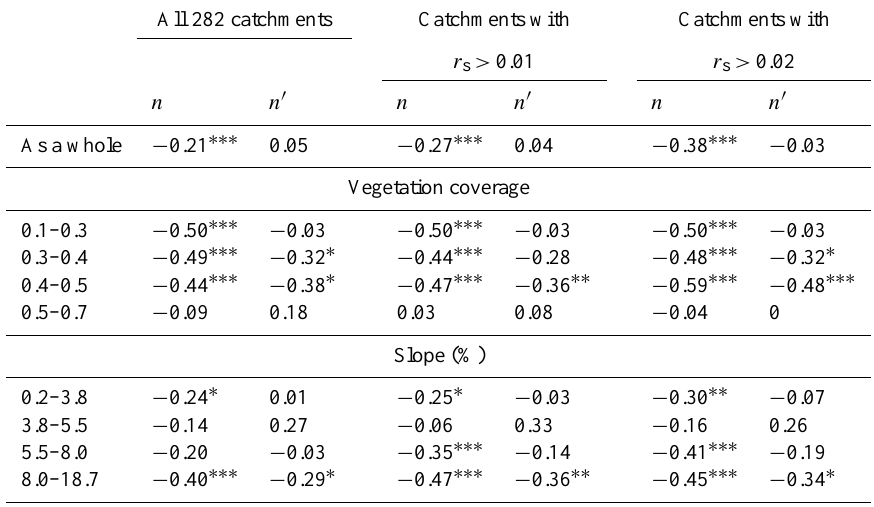
0.18 0.03 0 Slope